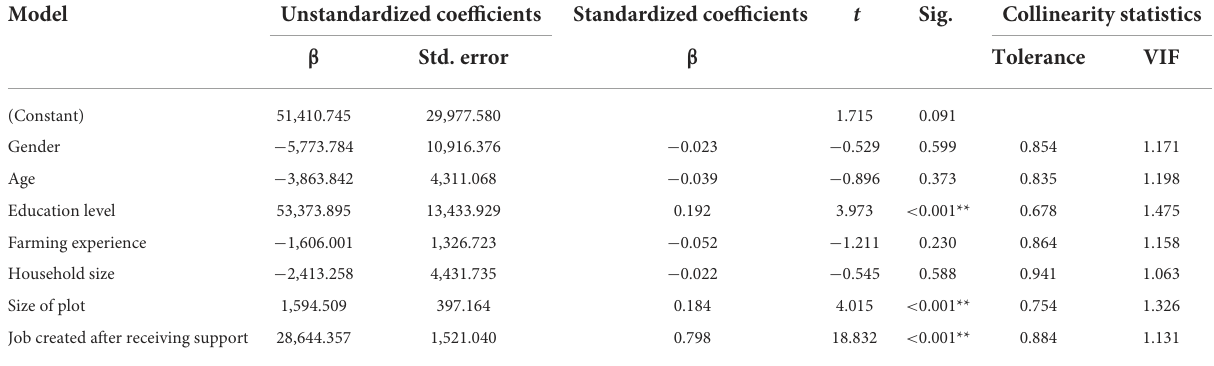
TABLE 4 Multiple linear regression results of the factors influencing annul net farm income in the post-support ( n = 196).